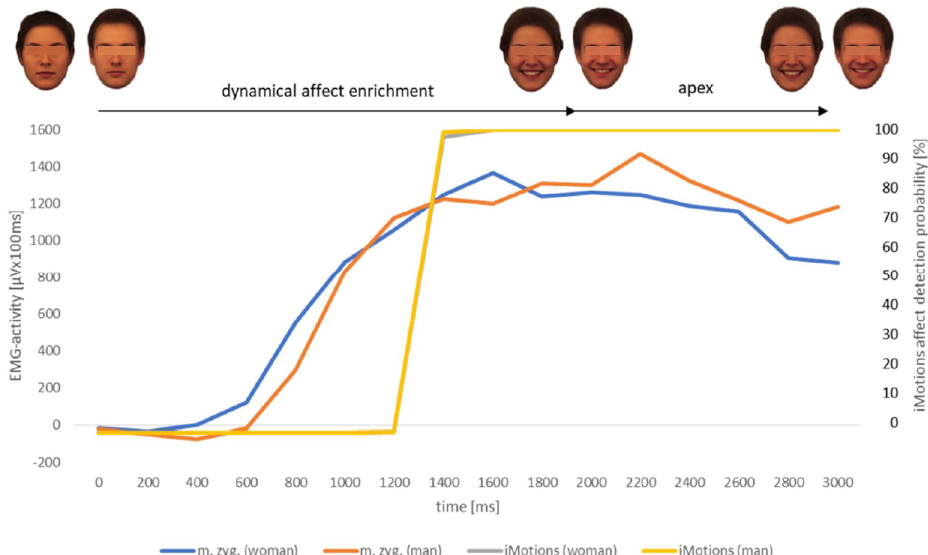
Fig 7. EMG-activity (N = 43) of m. zygomaticus [ μ Vx100ms] of healthy observers in response to the presented videoclips displaying the facial expression of happiness naturalistic evolving from a neutral face of the female respective male reference portrait; software based (AFFDEX/iMotions) affect detection probability values [%] of the same presented stimuli; measurement interval for both procedures 3000ms. m.zyg. (woman) = EMG-activity of musculus zygomaticus in response to the adult female face video. m.zyg. (man) = EMG-activity of musculus zygomaticus in response to the adult male face video. iMotions (woman) = software based affect detection probability [%] in response to the adult female face video. iMotions (man) = software based affect detection probability [%] in response to the adult male face video. The yellow (man) and grey (woman) lines are superposed within this graph because of a nearly similar time